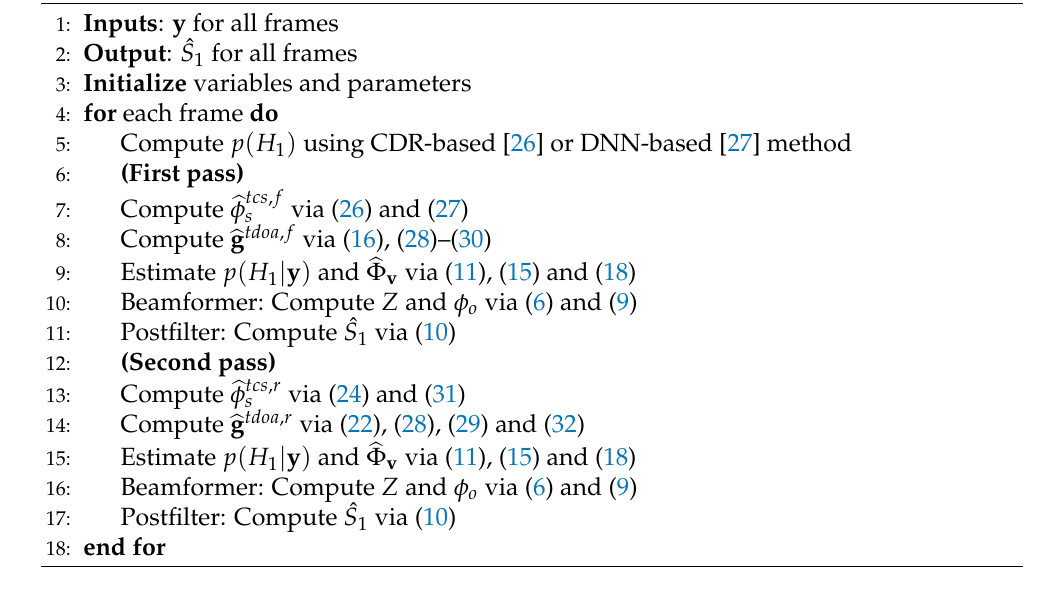
Algorithm 1 Proposed multi-microphone speech enhancement algorithm with improved speech SCM